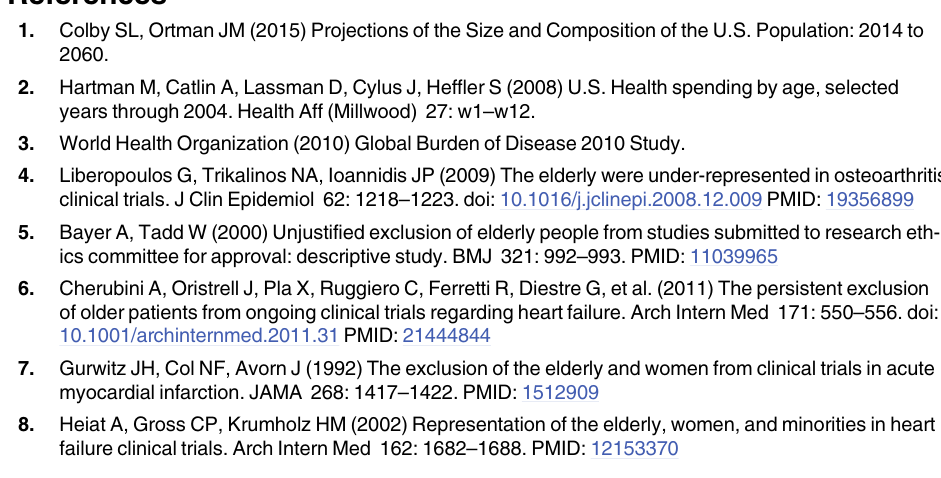
S1 Table. Disease categories and trials enrolling exclusively elderly persons, ordered according to DALYs per